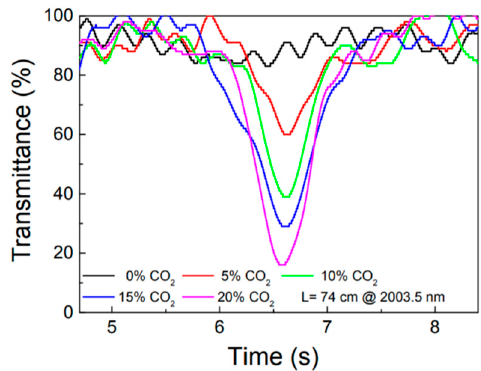
Figure 9. Photodetector signals recorded as the laser diode were tuned across the carbon dioxide transition. Spectra were measured for different CO 2 concentrations. In each spectrum, optical fringes are strong and clearly visible. Reprinted from [39].